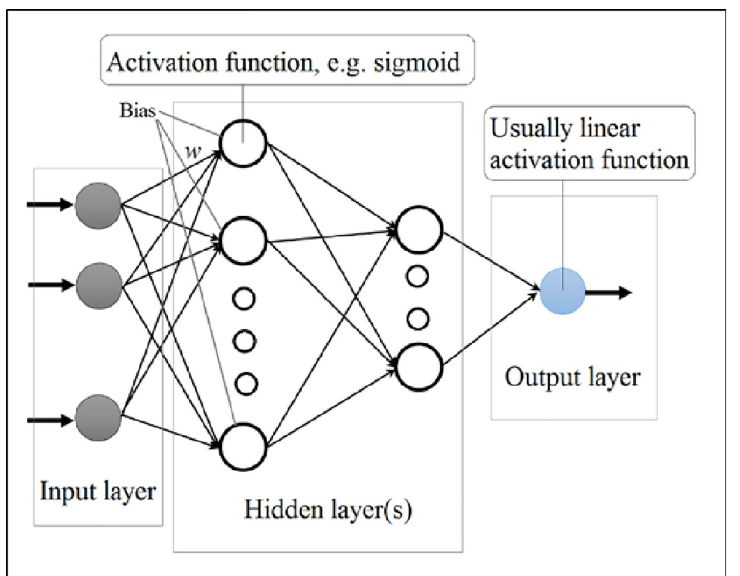
Fig 3. Schematic structure of a four-layer MLP neural